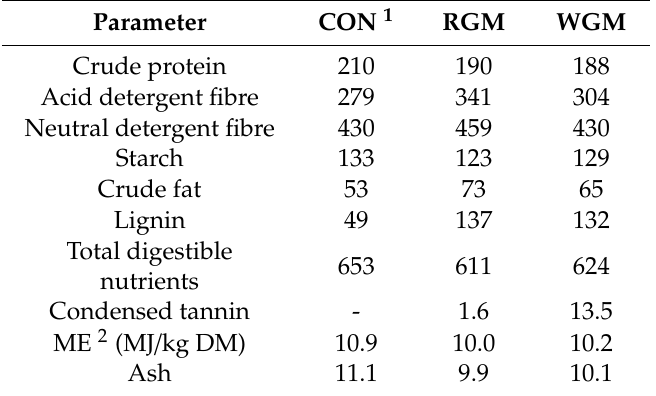
Table 3. Selected nutritional characteristics (g / kg DM unless otherwise specified) of the feed eaten by the